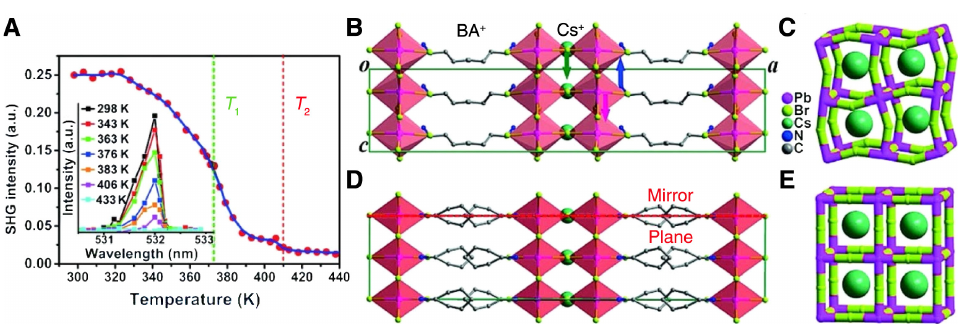
Figure 14: Temperature-dependent SHG responses and crystal structures of 2D ferroelectric perovskite. (A) Temperature-dependent SHG signals of (C temperatures. Crystal structures of (C and (C) the perovskite framework. The arrows indicate the relative displacements along the crystallographic c -axis. At 420 K: (D) highly symmetric structure packing and (E) perovskite framework. Reprinted from Ref. [186] with permission from the